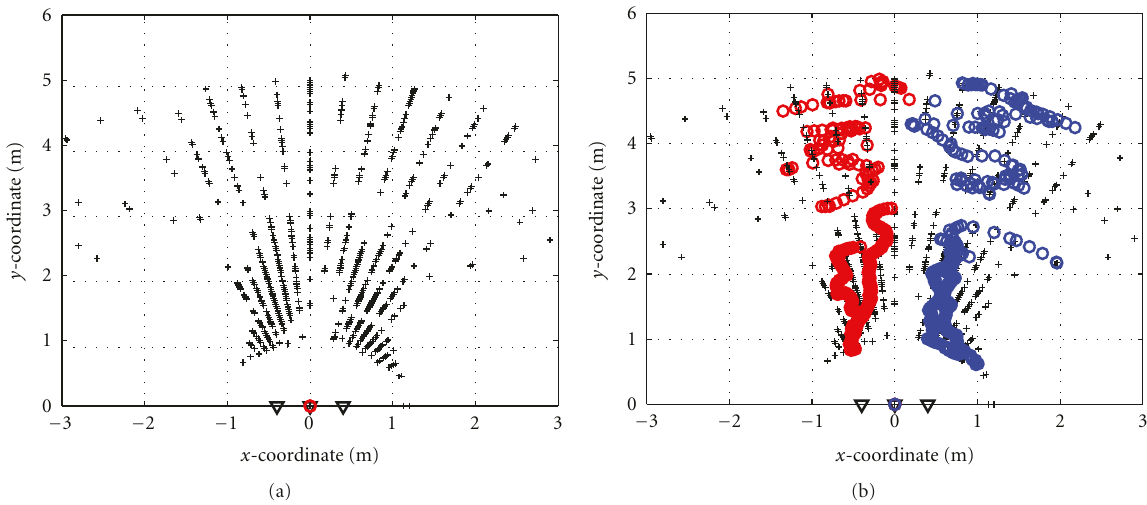
Figure 7: (a) Target positions estimated by the direct localization, (b) target tracks estimated by the MTT system.